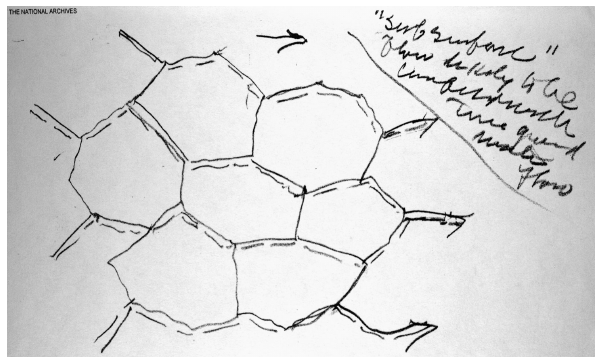
Figure 2. Figure explaining lateral, subsurface flow in Sun cracks as concealed surface runoff. Source: drawing in Horton’s hand from Box 71 of the Horton Papers in the US National